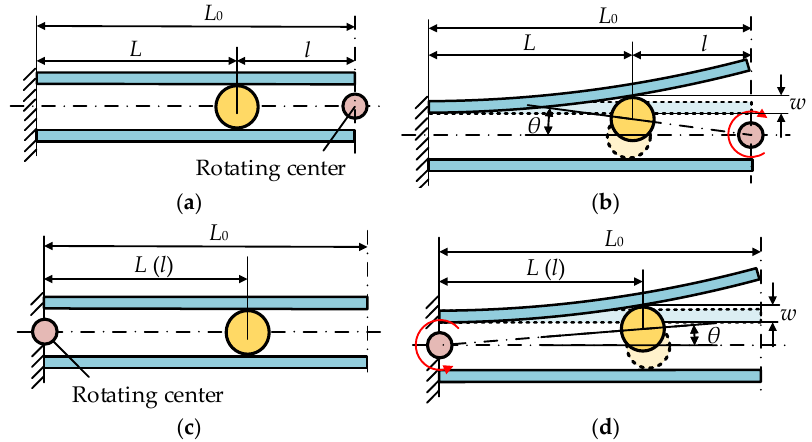
Figure 2. Two arrangements of the rotating center. ( a ) The rotating center is at the free end of the leaf springs (initial state). ( b ) The rotating center is at the free end of the leaf springs (transmission state). ( c ) The rotating center is at the fixed end of the leaf springs (initial state). ( d ) The rotating center is at the fixed end of the leaf springs (transmission state).